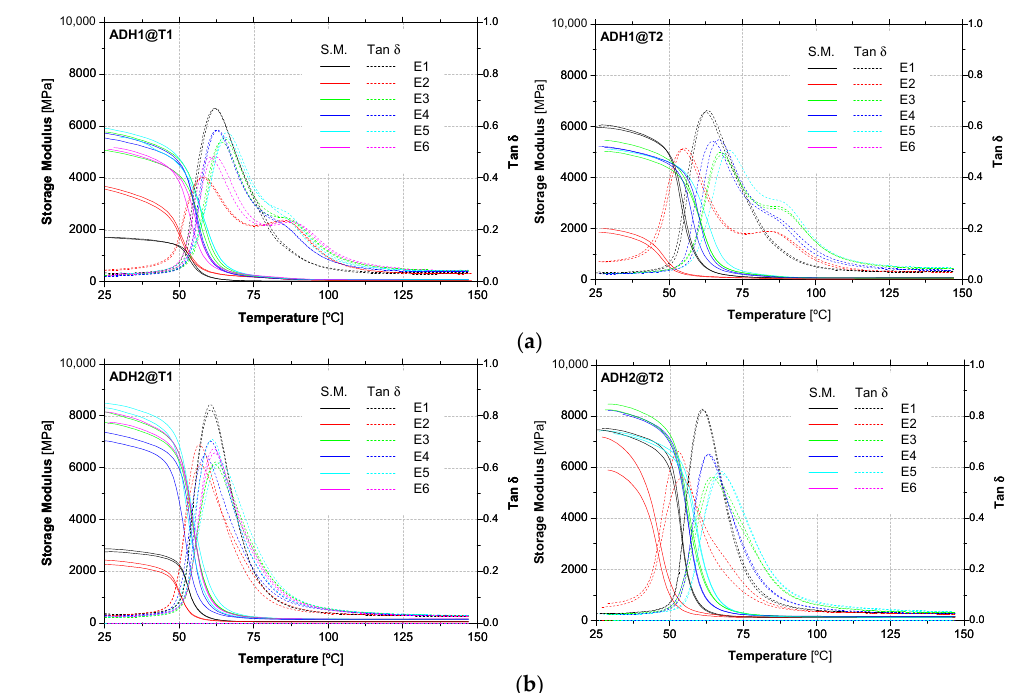
Figure 10. DMA experimental curves of adhesives ( a ) ADH1 and ( b ) ADH2, after one year (T1) and two (T2) years of exposure to the environments studied (E1 to E6).